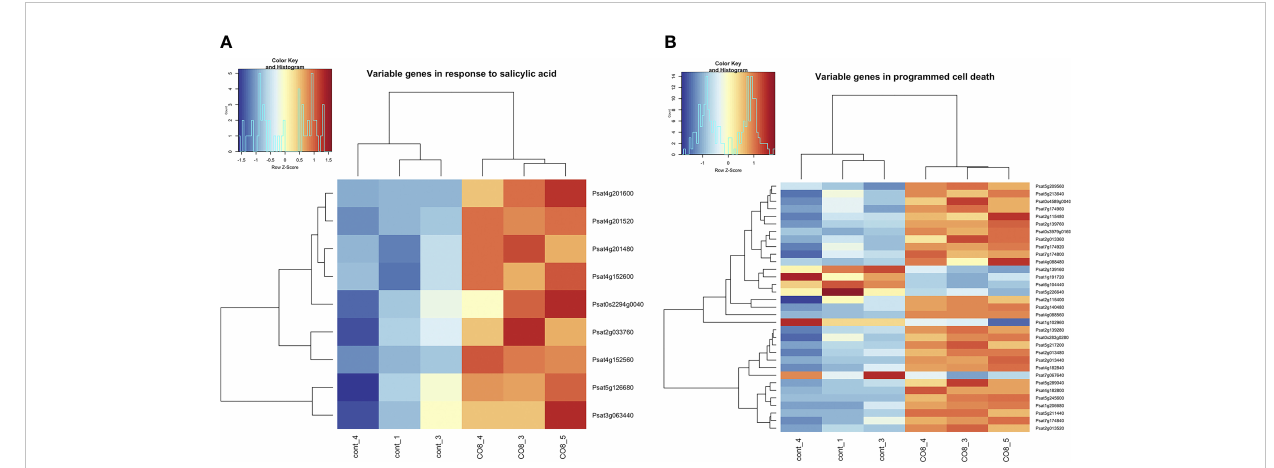
FIGURE 3 Heatmap of gene expression levels after CO8-DA treatment (3 biological replicas) in comparison to control (Jensen ’ s medium) (3 biological replicas). The list of genes that changed expression levels and were annotated in Gene Ontology terms as a part of “ response to salicylic acid ” (A) and “ programmed cell death ” (B) biological processes in pea roots 24 h after